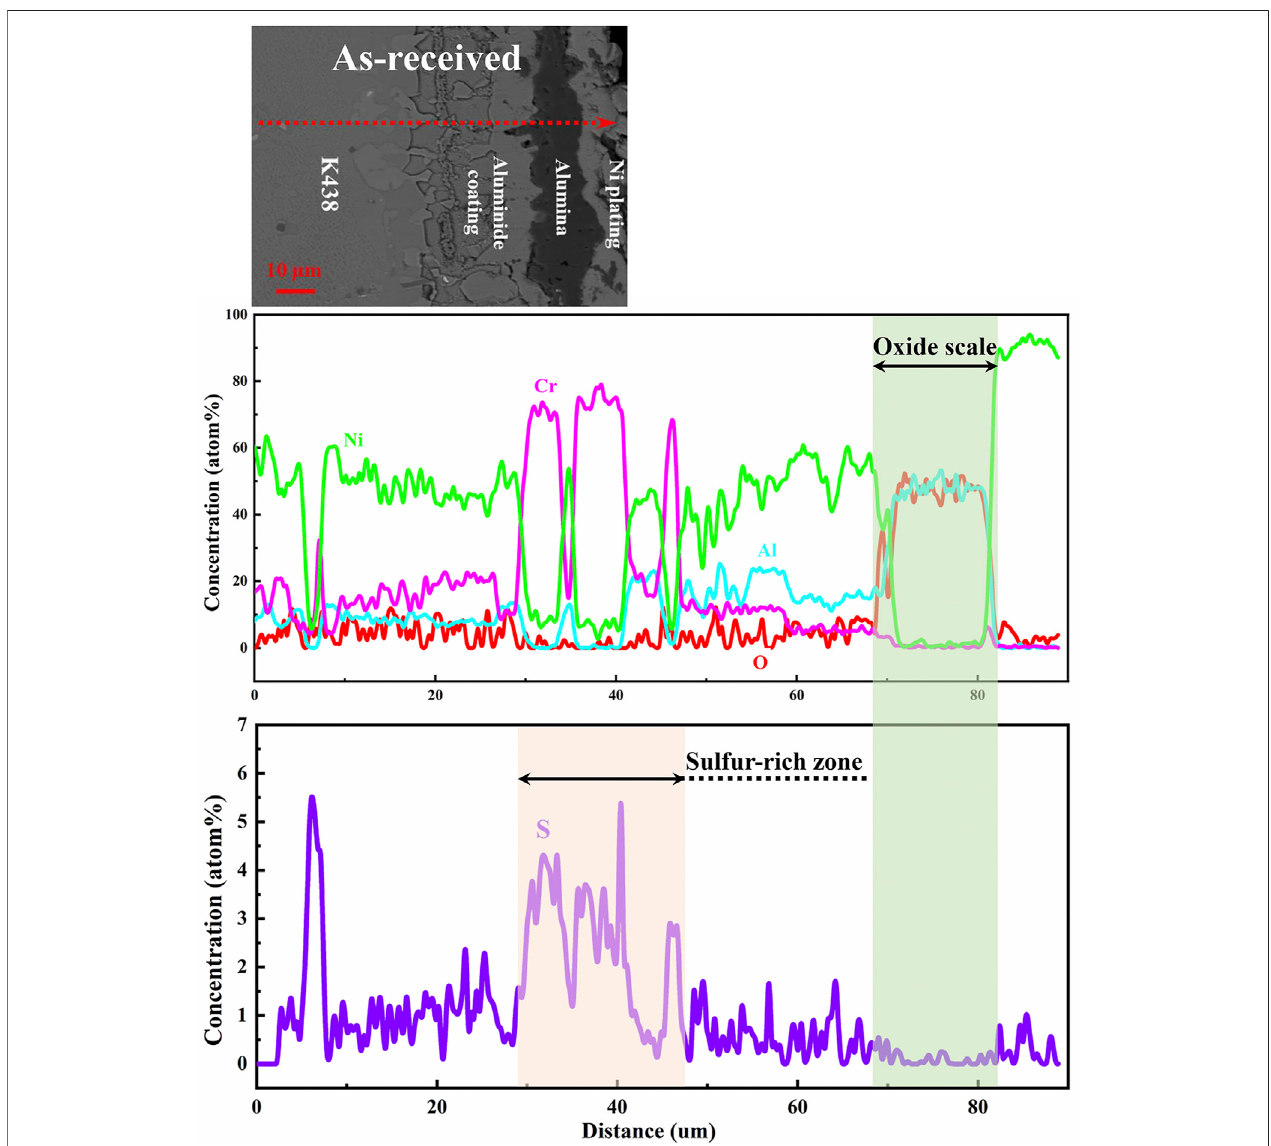
FIGURE 6 | Line scan of the as-received aluminide coating cross section after hot corrosion for 120 h in Na 2 SO 4 salt at 1050 ° C.